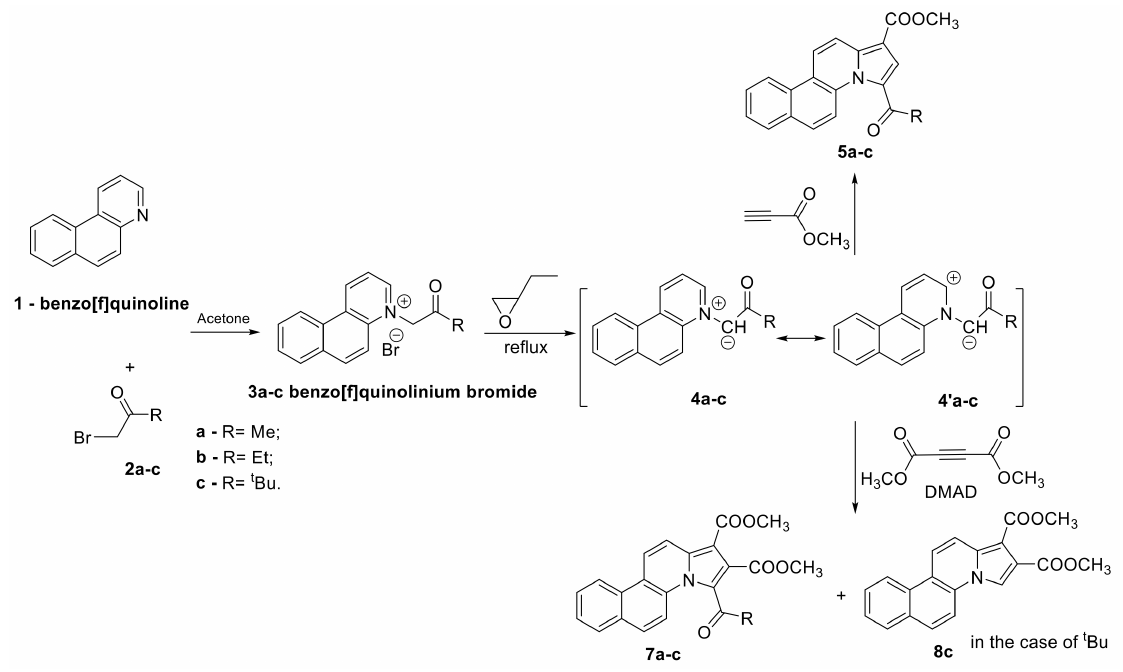
Scheme 1. Reaction pathway to generate azasteroid